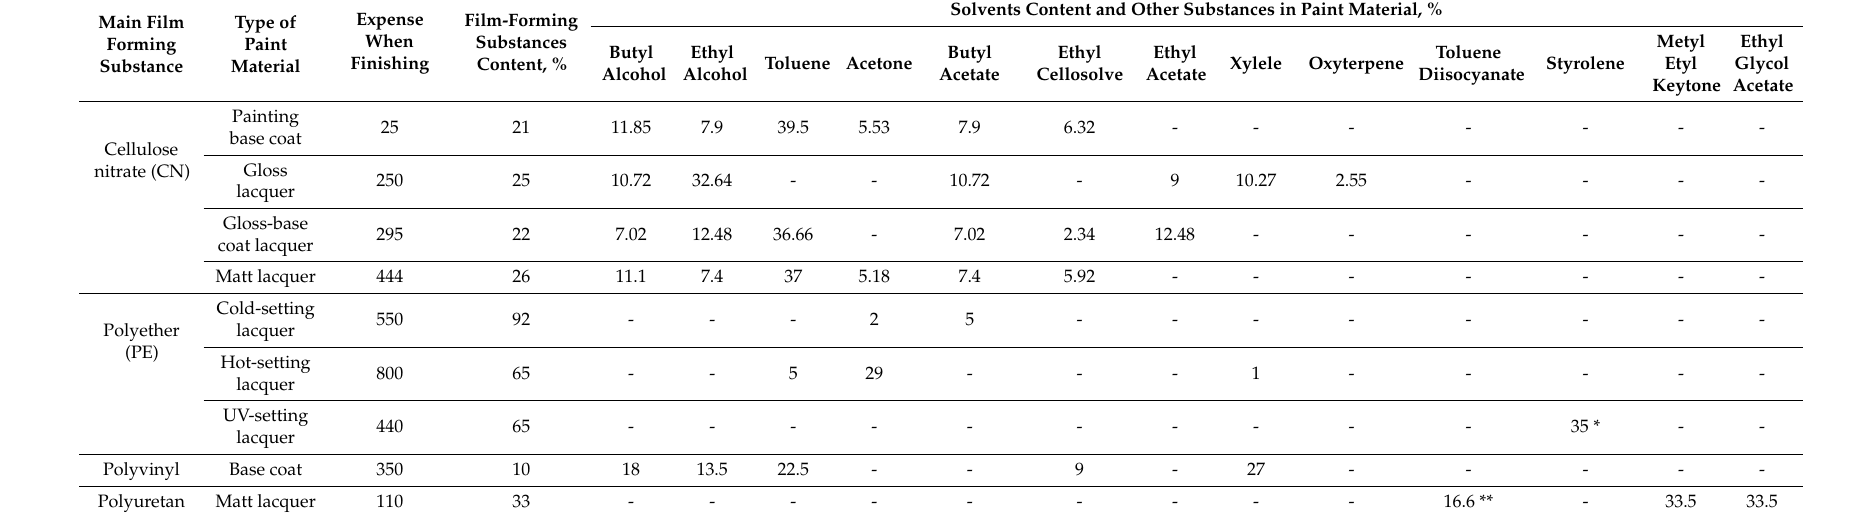
Table 2. Brief description and content of various solvents and substances in paints and